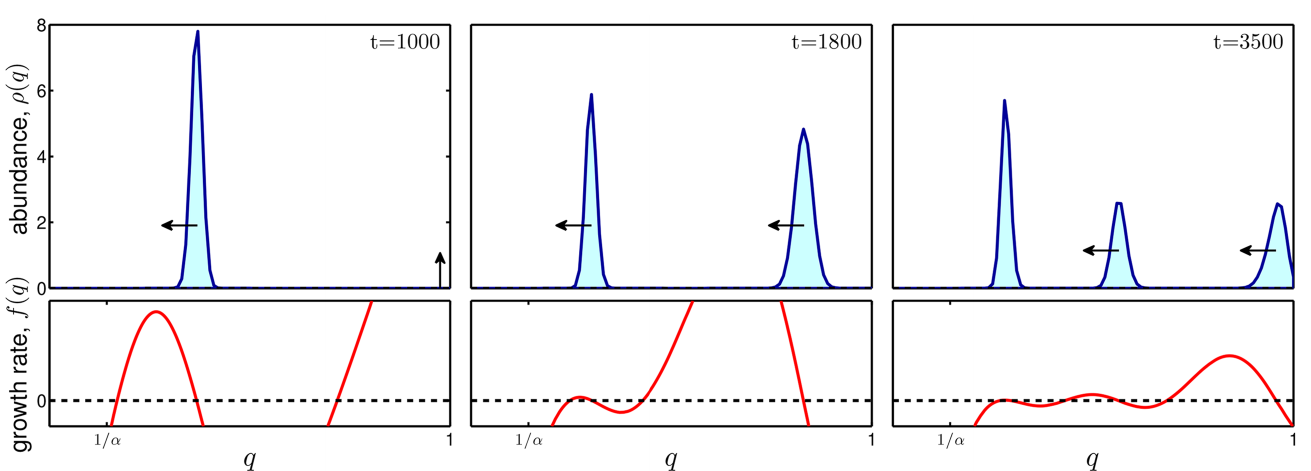
Fig 4. Emergence of polymorphic populations. Time evolution of the distribution of trait values, ρ t ( q ), (Eq (3)) is characterized by a series of emerging morphs with high values of q , which in turn evolve towards lower values of q . Morphs emerge when the densities of more competitive morphs become sufficiently low, which results in a positive per-capita, per-cycle growth, f ( q ), for sufficiently large q . The morphs evolve leftwards to greater competitiveness as long as mutants with slightly lower q have a positive f ( q ). Here the cooperative trait variant of our model is considered. Parameters: s = 18, α = 2.5, ^ a ¼ 3 , μ = 1, F ( q ) = − q , Δ q =